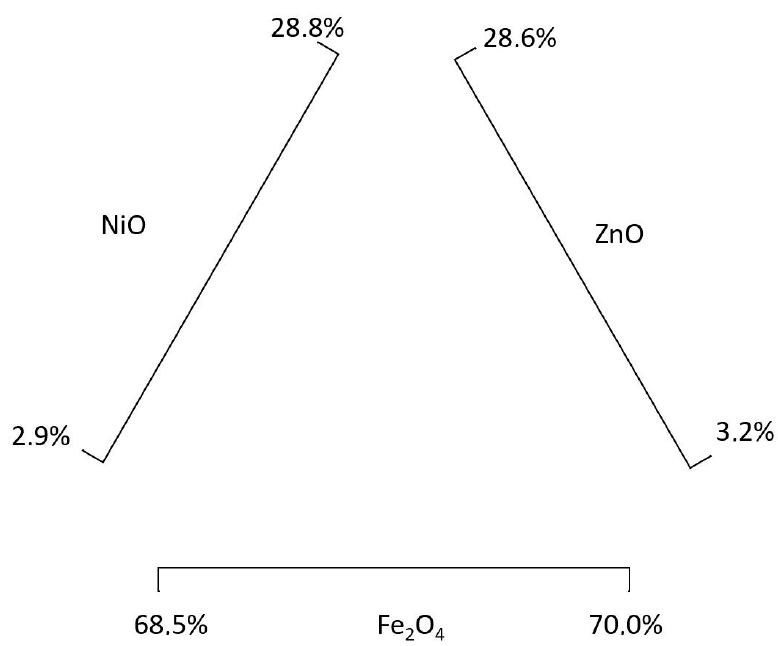
Figure 3. NiZn soft ferrite composition diagram.